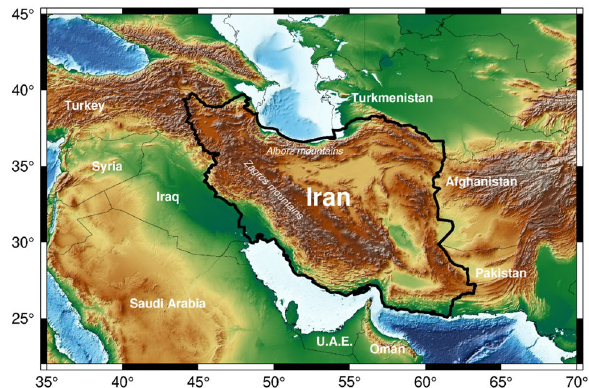
Figure 1. The location of Iran in the Middle East and its neighboring countries. It is generated using the Generic Mapping Tools